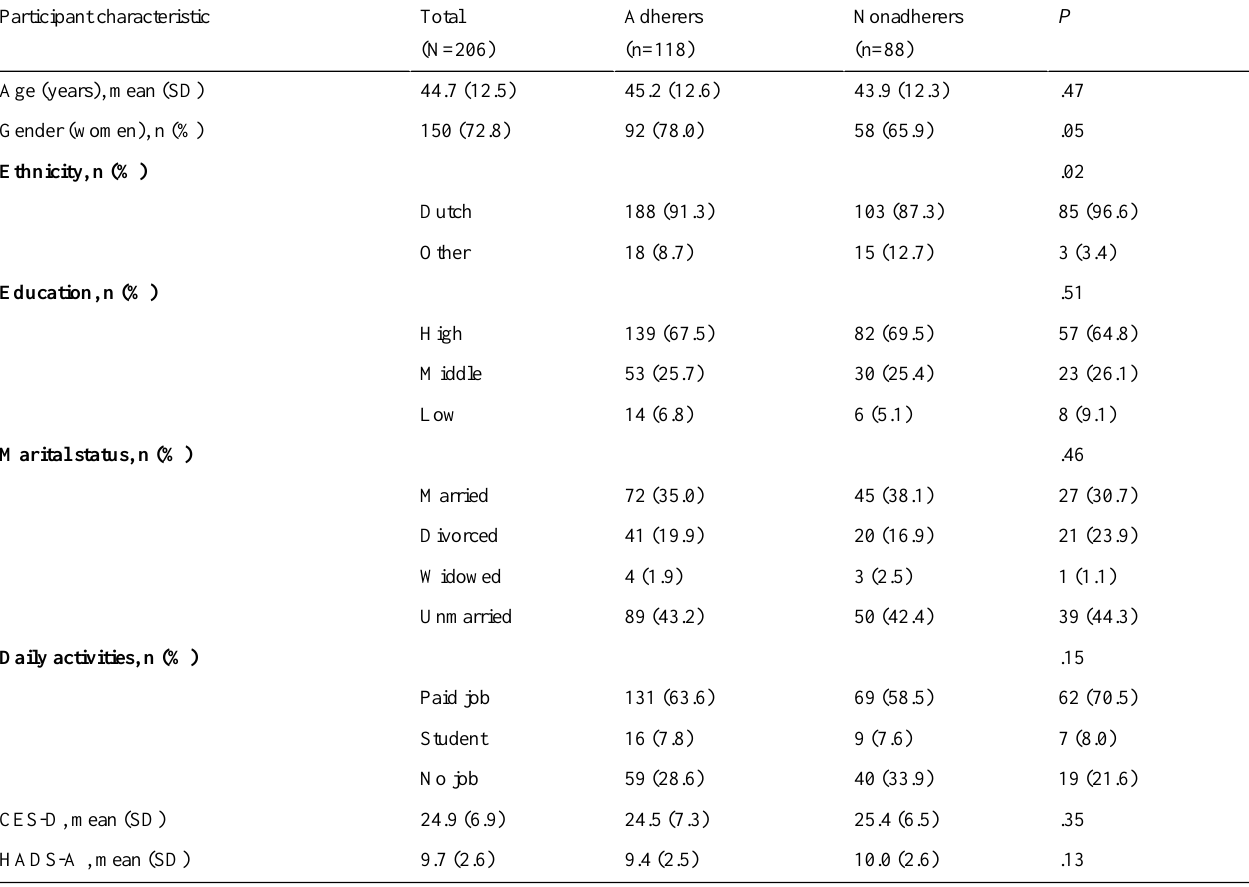
Table 1. Baseline demographics and outcome measures of all participants, and differences between adherers and nonadherers.